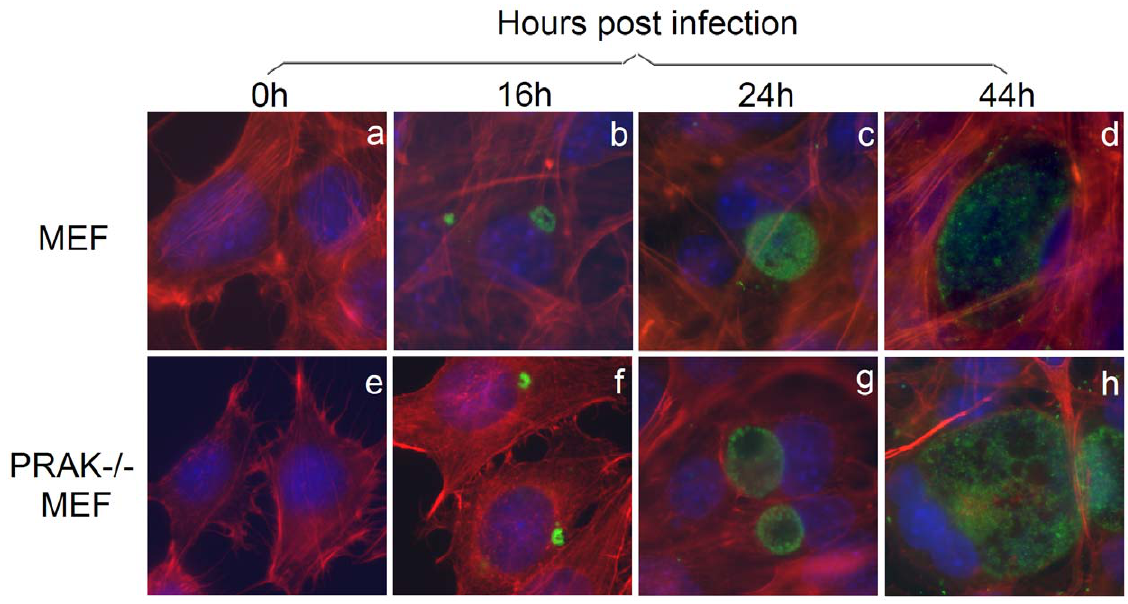
Figure 3. Replication of C.trachomatis organisms in PRAK-deficient mouse embryo fibroblast cells. Mouse embryo fibroblast cells (MEF) without (panels a–d) or with (e–h) PRAK deficiency (PRAK 2 / 2 ) were infected with (b–d & f–h) or without (a & e) C. trachomatis (MOI=0.5) for various periods of time as indicated on top of the figure. The cultures were processed for immunofluorescence assay with a rabbit antibody for visualizing chlamydial organisms (green), Alexa-Fluor 568 Phalloidin for host cell F-actin (red) and Hoechst dye for DNA (blue). Note that the inclusion sizes were similar in MEF with or without PRAK deficiency.